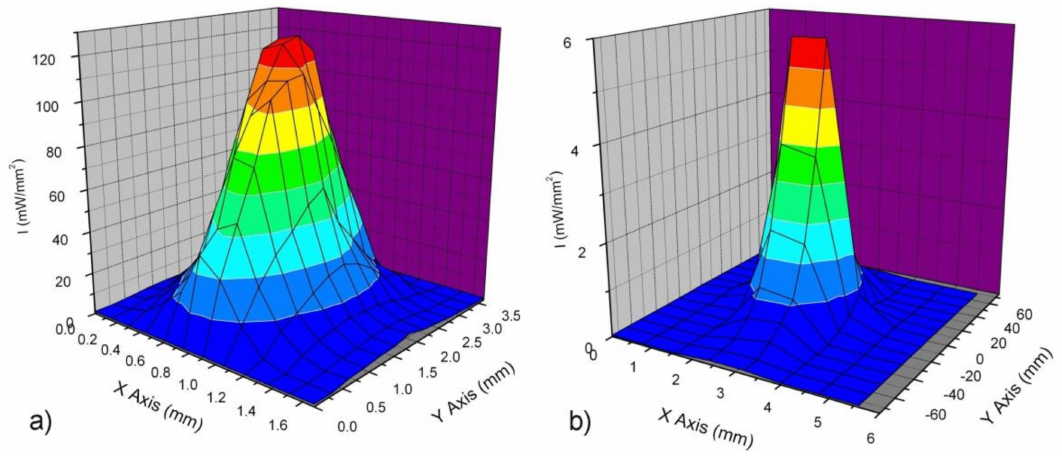
Figure 3. Intensity distribution of the laser beam for Mode I ( a ) and Mode II ( b )